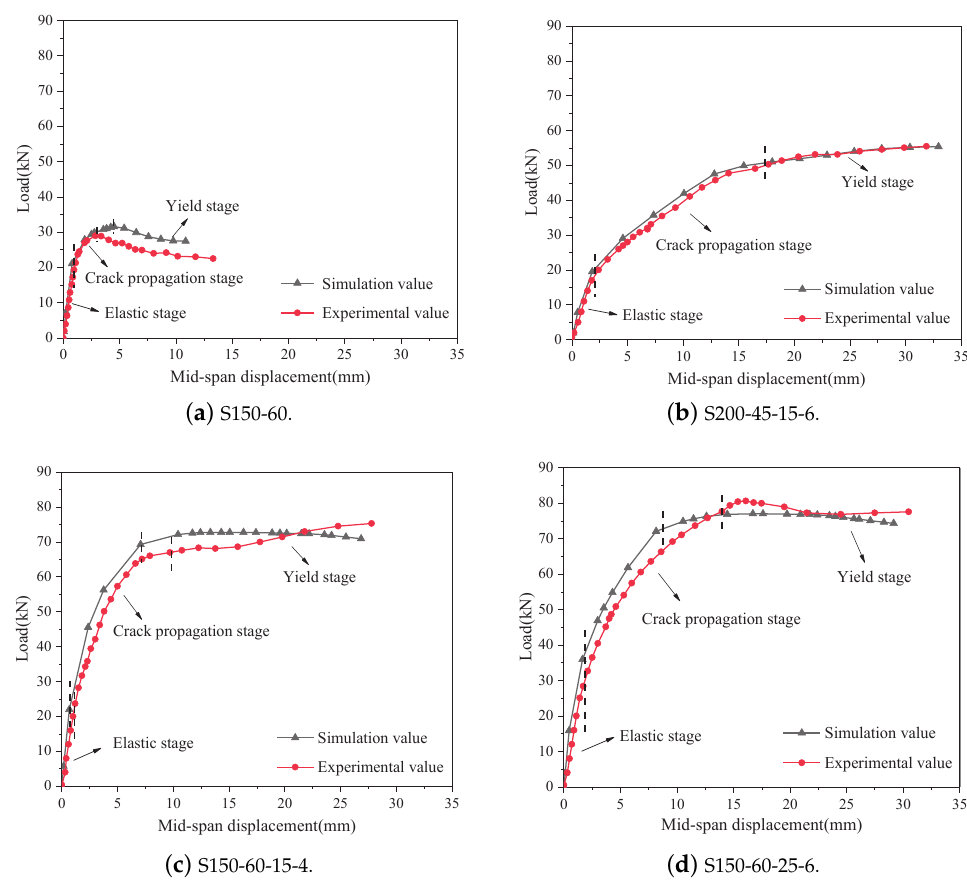
Figure 5. Specimens after failure.